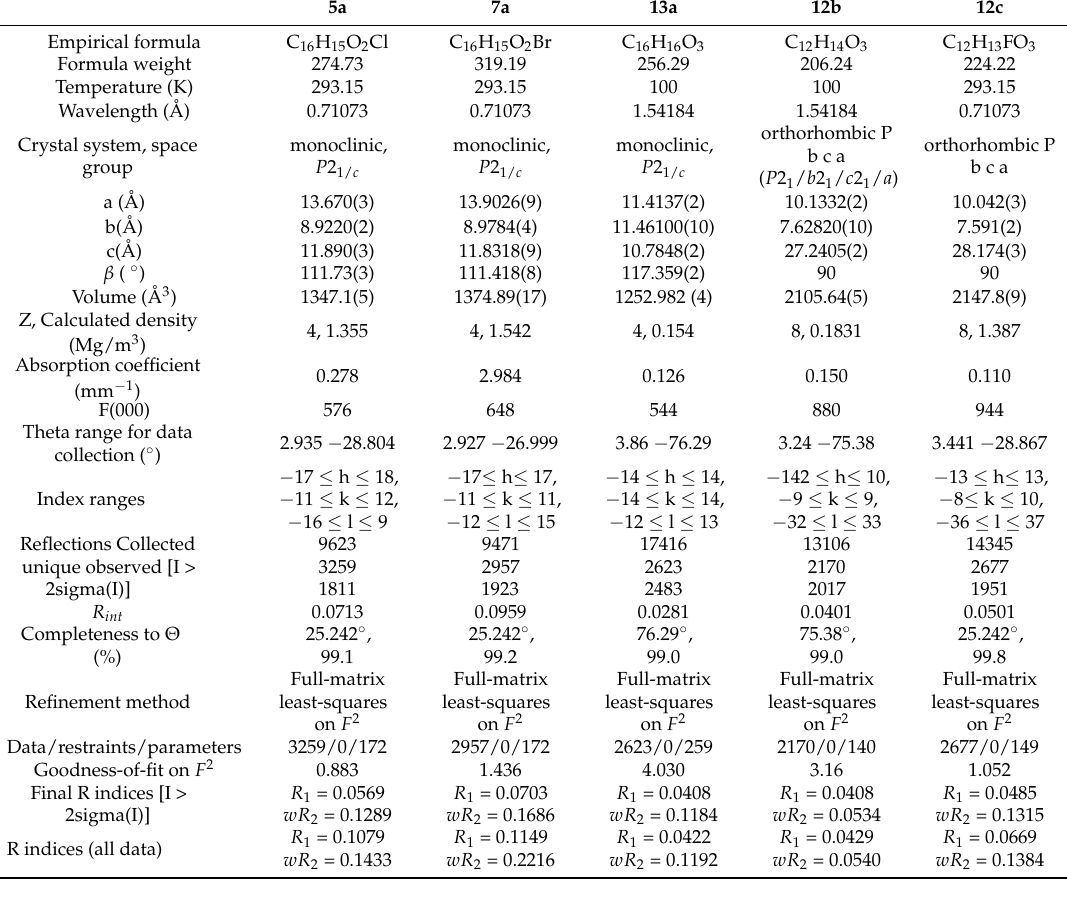
Table 6. Experimental details of the crystallographic analysis for lactones 5a , 7a , 13a , 12b and 12c .